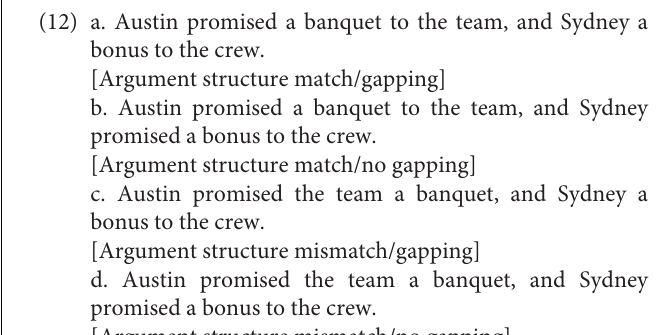
FIGURE 3 | Mean acceptability ratings for all conditions (Experiment 2a).